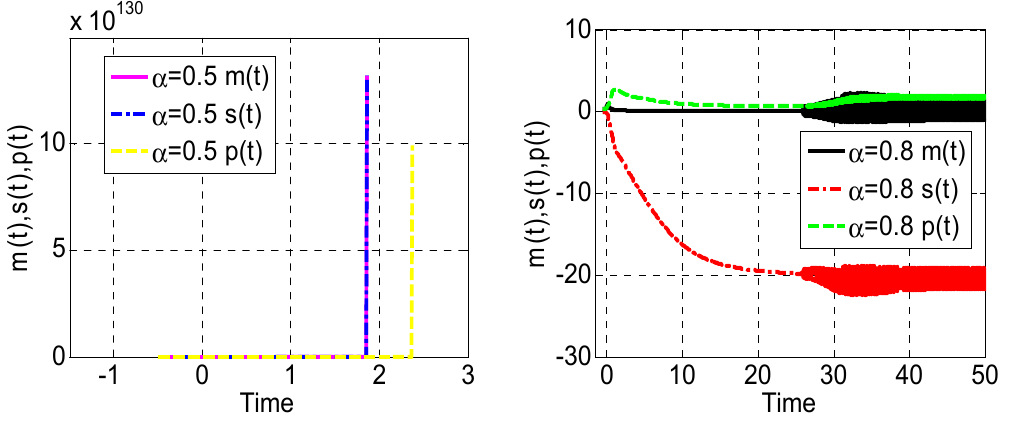
Figure 7. Time response sequence diagram of the three-dimension FOGRN when α =